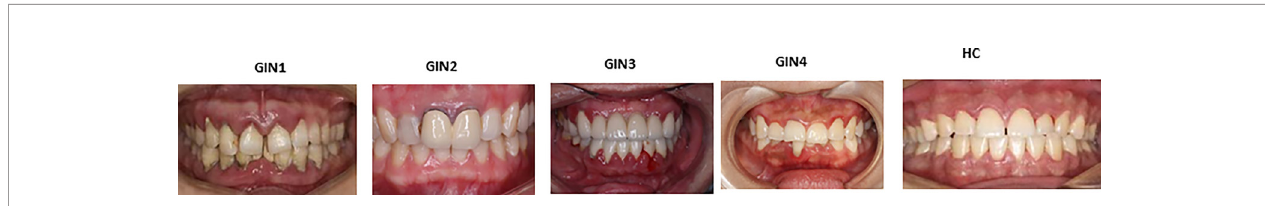
FIGURE 1 | Clinical manifestations of gingivitis participants and healthy controls.